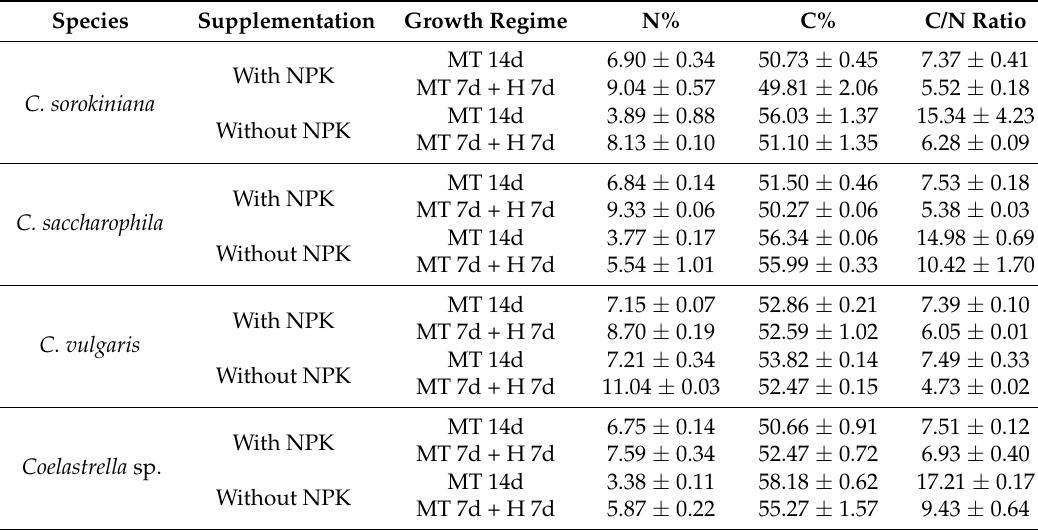
Table 4. Percentage of total nitrogen (N) and total carbon (C) per DW, as well as the C/N ratio of C. sorokiniana , C. saccharophila , C. vulgaris, and Coelastrella sp. grown in a birch hydrolysate and dairy effluent with or without NPK supplementation. The species were cultivated for 14 days mixotrophically (MT 14d), or for 7 days mixotrophically, and then another 7 days heterotrophically (MT 7d + H 7d). Values are expressed as mean ± standard deviation ( n =